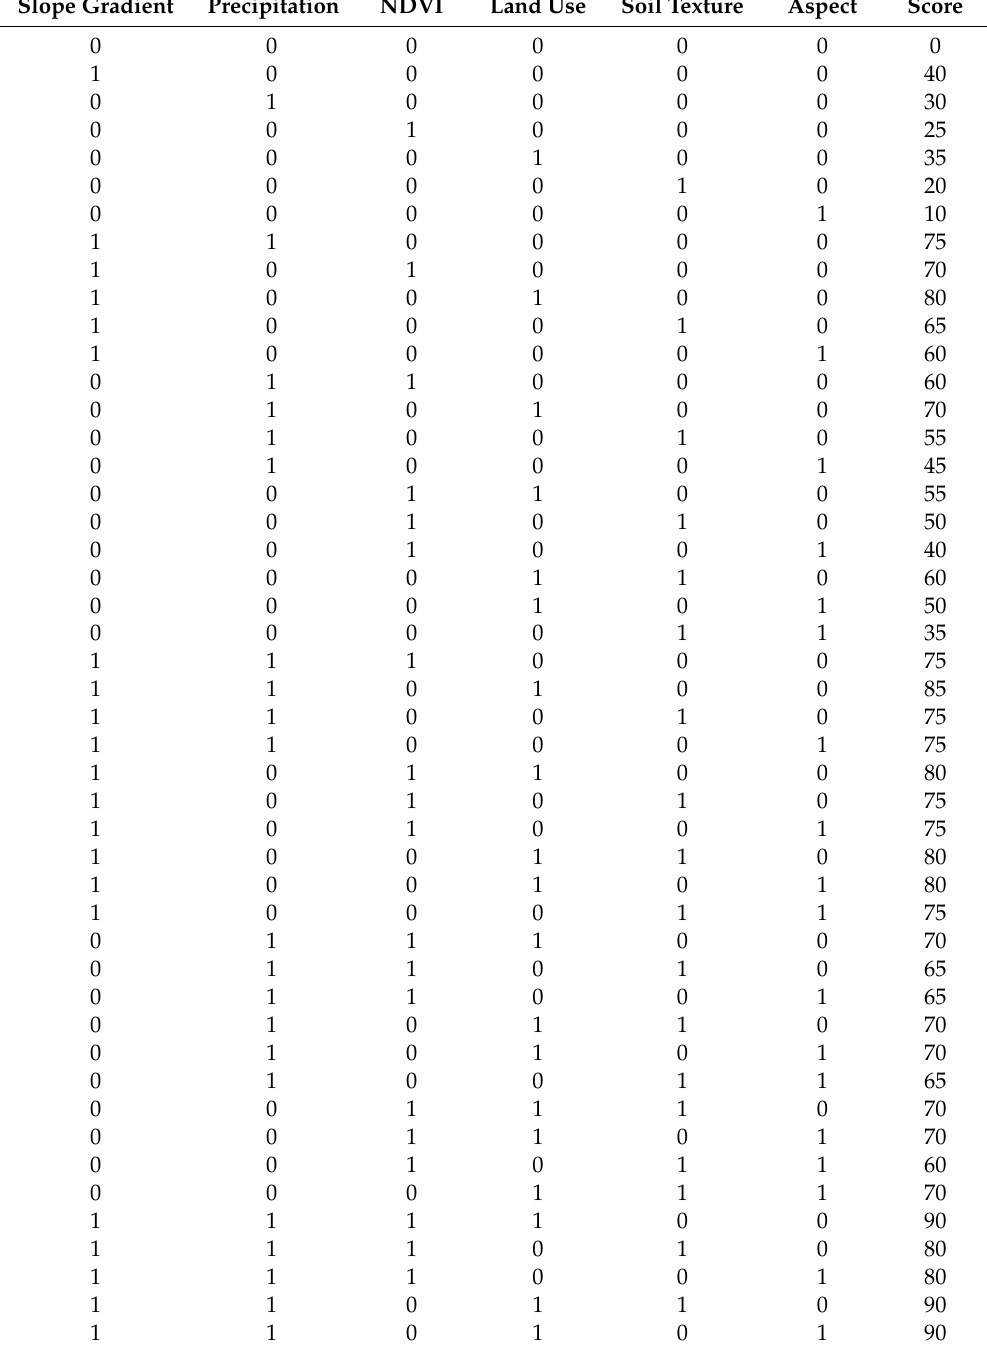
Table 4. Questionnaire for experts to define the measure scores related to each possible coalition of criteria used in soil erosion risk